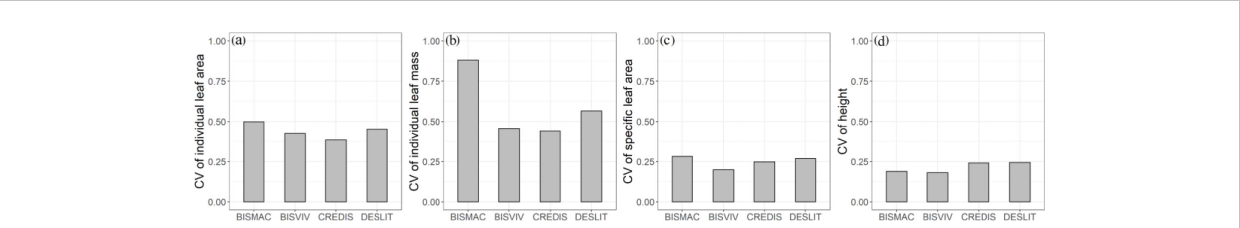
FIGURE 2 Intraspeci fi c trait variation in individual leaf area (A) , individual leaf area (B) , speci fi c leaf area (C) , and height (D) for BISMAC ( Bistorta macrophylla ), BISVIV ( Bistorta vivipara ), CREDIS ( Cremanthodium discoideum ), and DESLIT ( Deschampsia littoralis